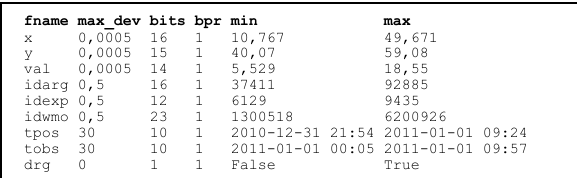
Table 3. Header for a dataset of ARGOS drifting buoy